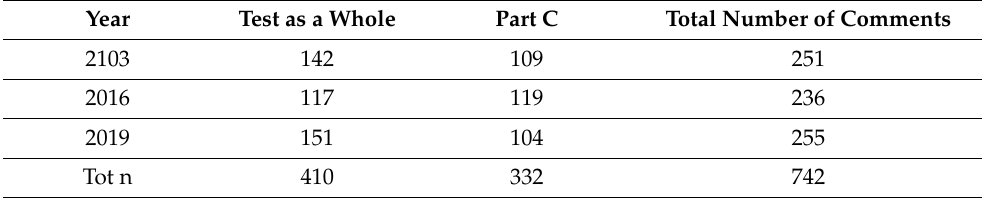
Table 2. Number of teachers’ comments analyzed (2013, 2016 and